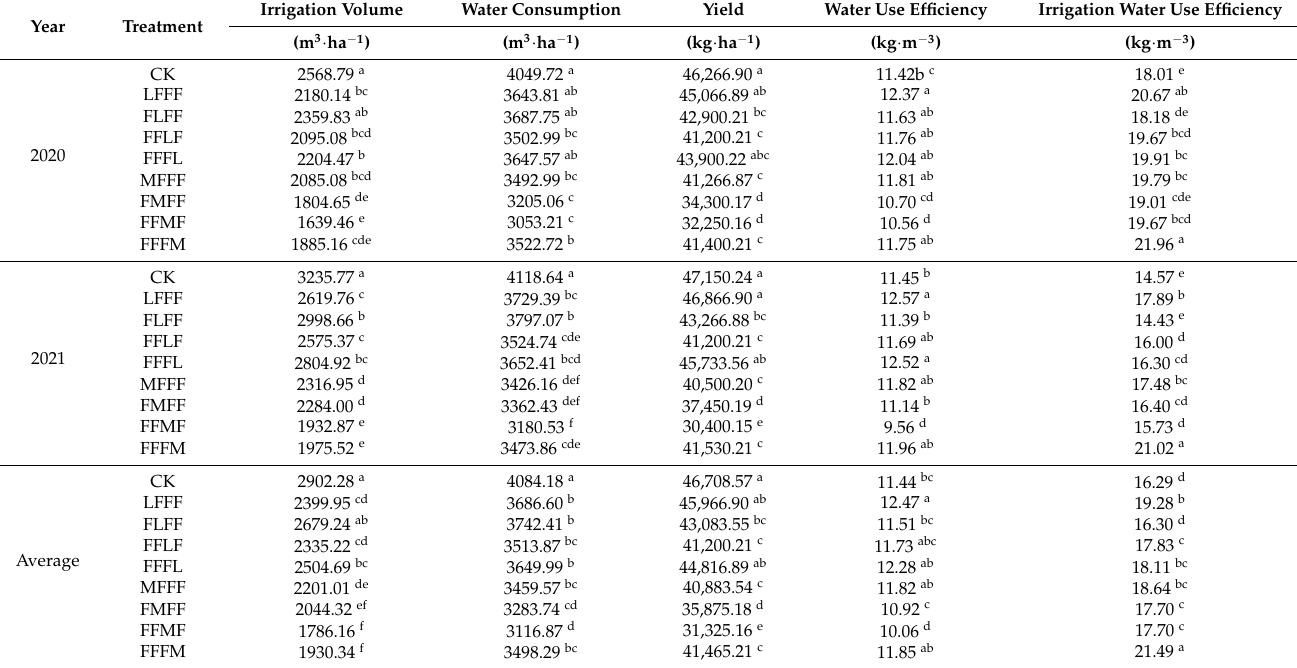
Table 2. Effects of different deficit irrigation treatments on water consumption, yield, water use efficiency and irrigation water use efficiency of